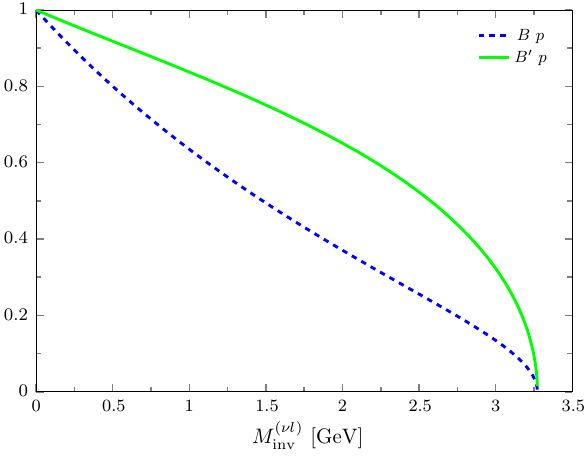
Fig. 2 Values of Bp and B (cid:7) p as a function of M (ν l ) of Eqs. (9), (7) inv (ν l ) Bp , B (cid:7) p as a function of M in Fig. 2. We can see that inv B (cid:7) p is always bigger than Bp and that both Bp and B (cid:7) p go (ν l ) → 0 (for m = m ν = 0). Moreover, when to unity as M l inv (ν l ) M goes to its maximum, then p → 0 and Bp , B (cid:7) p go to inv zero.